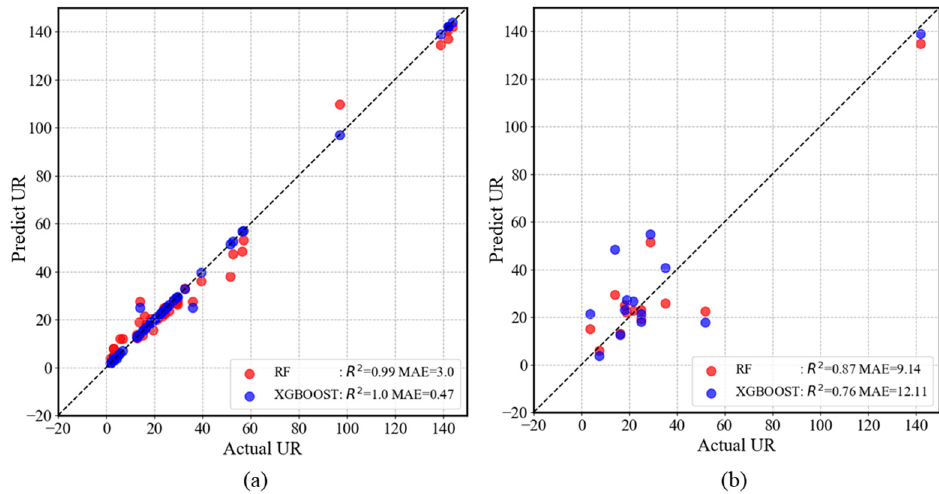
Figure 6. Prediction results under RF and XGBOOST ML models, ( a ) training data ( b ) testing data.